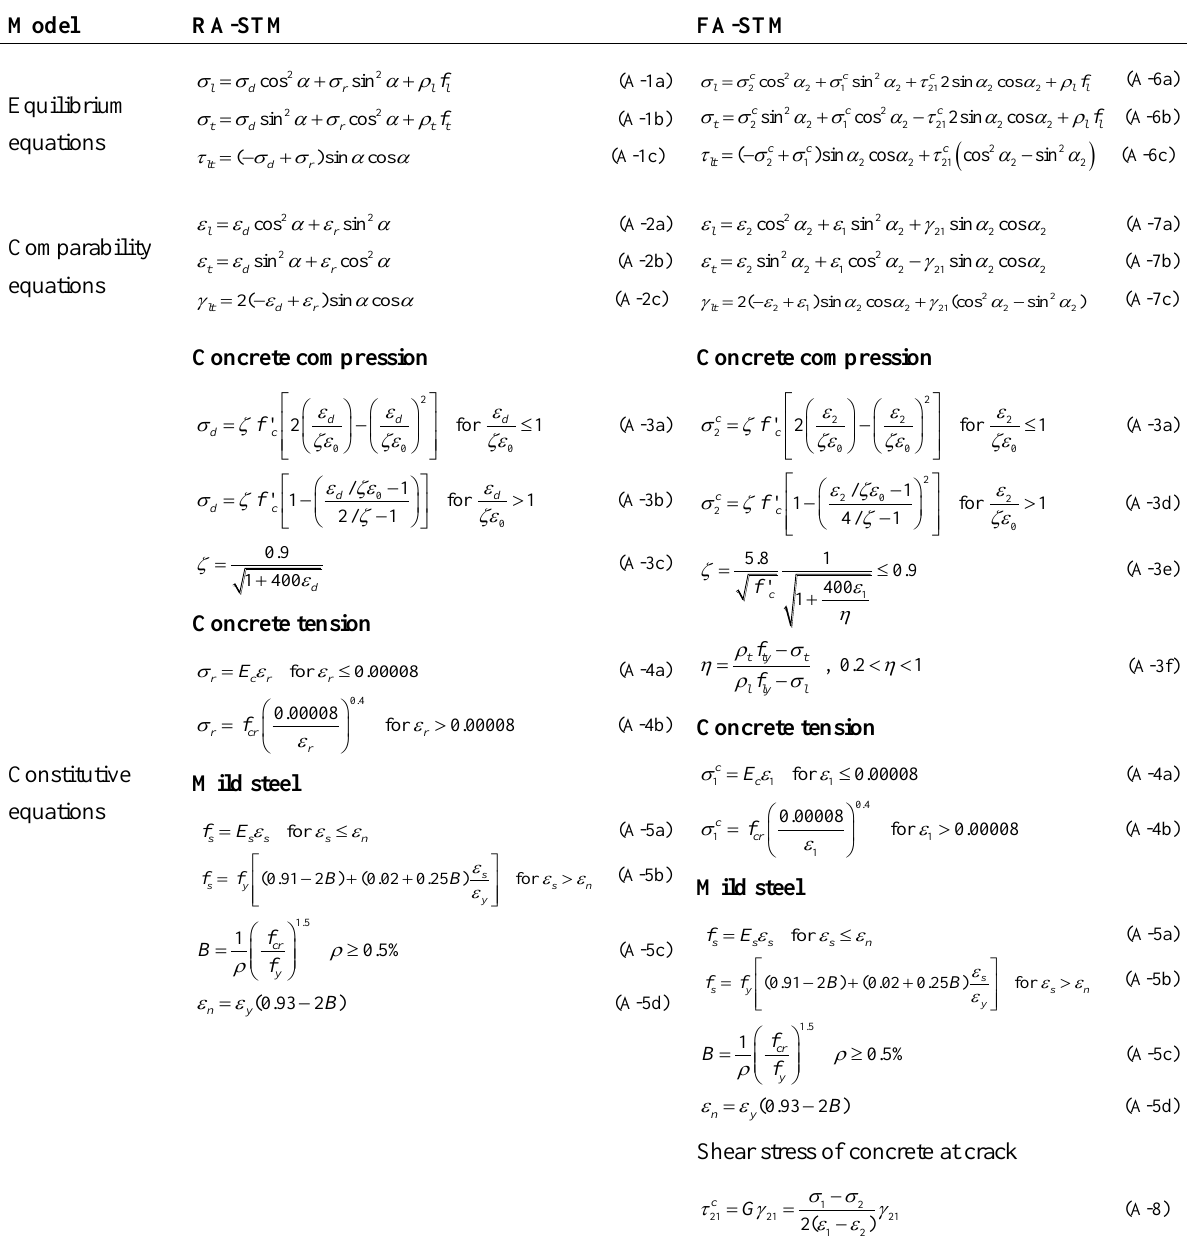
Table A-1. Equations in RA-STM and